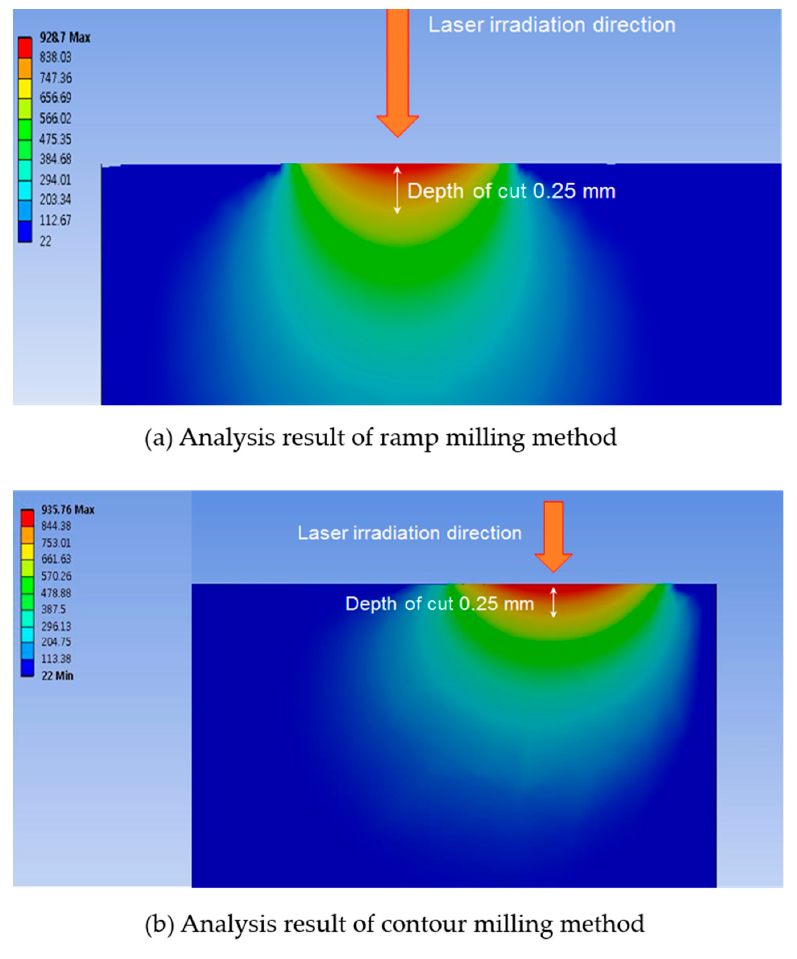
Figure 10. Analysis results of ramp milling ( a ) and contour milling ( b ) in the Inconel 718. Table 4 . Maximum temperature of Inconel 718 each laser power.